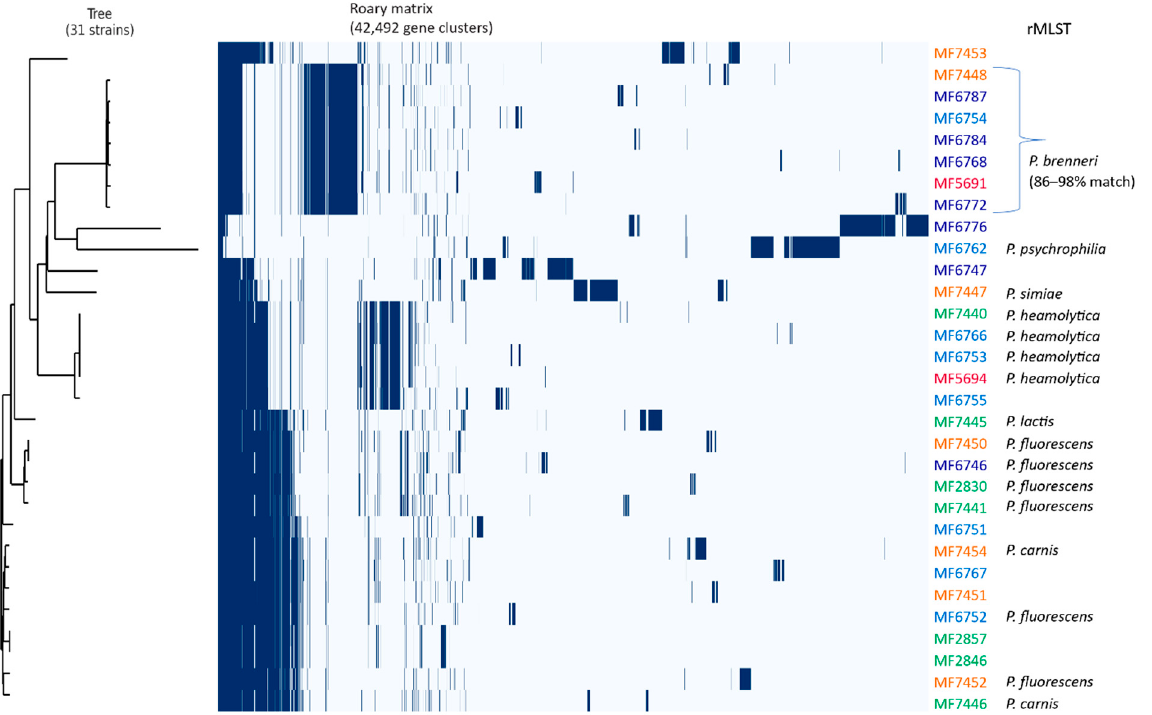
Figure 3. Core gene alignment tree. The presence or absence of 42,492 aggregated pan-genome genes in 31 isolates is shown. Blue denotes that a gene is present in the corresponding isolate (identified by isolate name to the right). The isolate names are colored according to the collection number (see Figure 1). Species assignment is shown according to rMLST for isolates with 100% match (except for P. brenneri ).